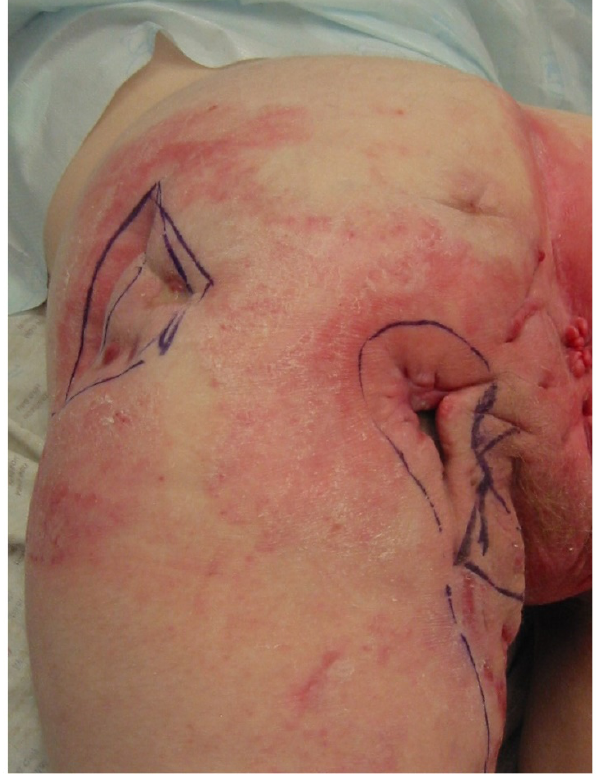
Figure 1. Extensive osteomyelitis in a paraplegic patient with sinus drainage from the ischium, trochanteric region and